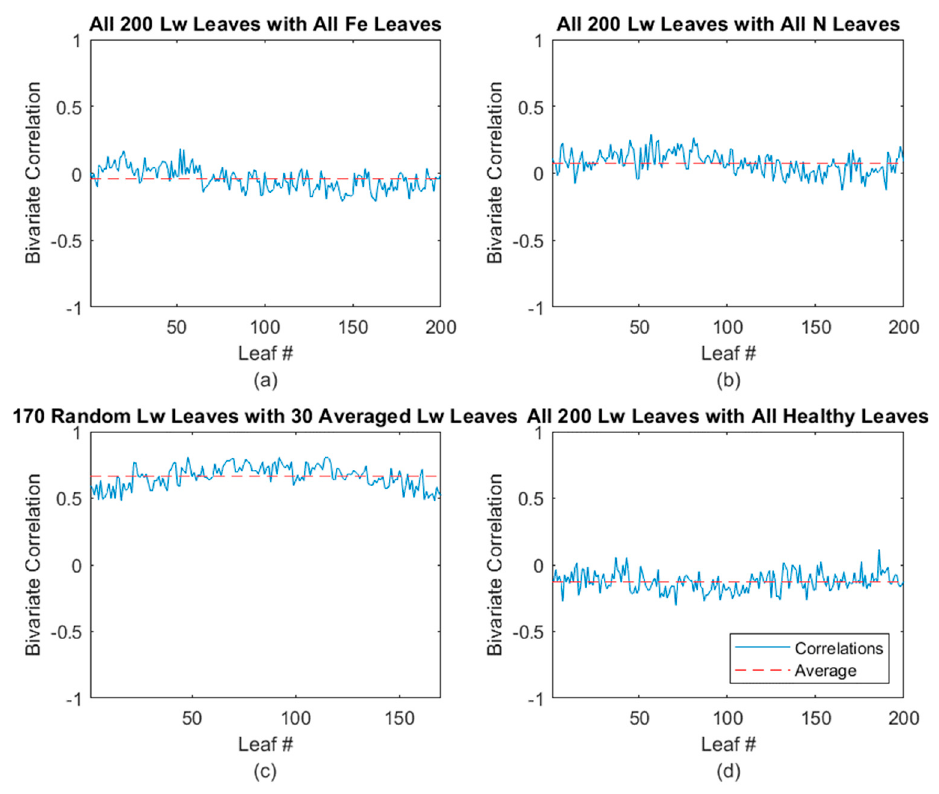
Figure 7. FDA-BC algorithm applied for Lw-diseased avocado leaves: ( a ) Lw correlated with Figure 7. FDA ‐ BC algorithm applied for Lw ‐ diseased avocado leaves: ( a ) Lw correlated with Fe ‐ Fe-deficient; ( b ) Lw correlated with N-deficient; ( c ) Lw correlated with Lw; and ( d ) Lw correlated deficient; ( b ) Lw correlated with N ‐ deficient; ( c ) Lw correlated with Lw; and ( d ) Lw correlated with with healthy.